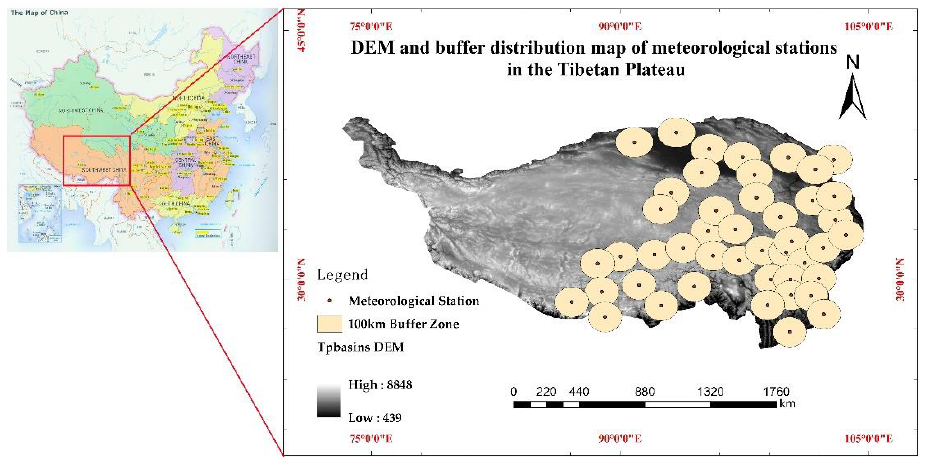
Figure 3. Map of the study area with meteorological stations (map on the left shows the location of study area in China).